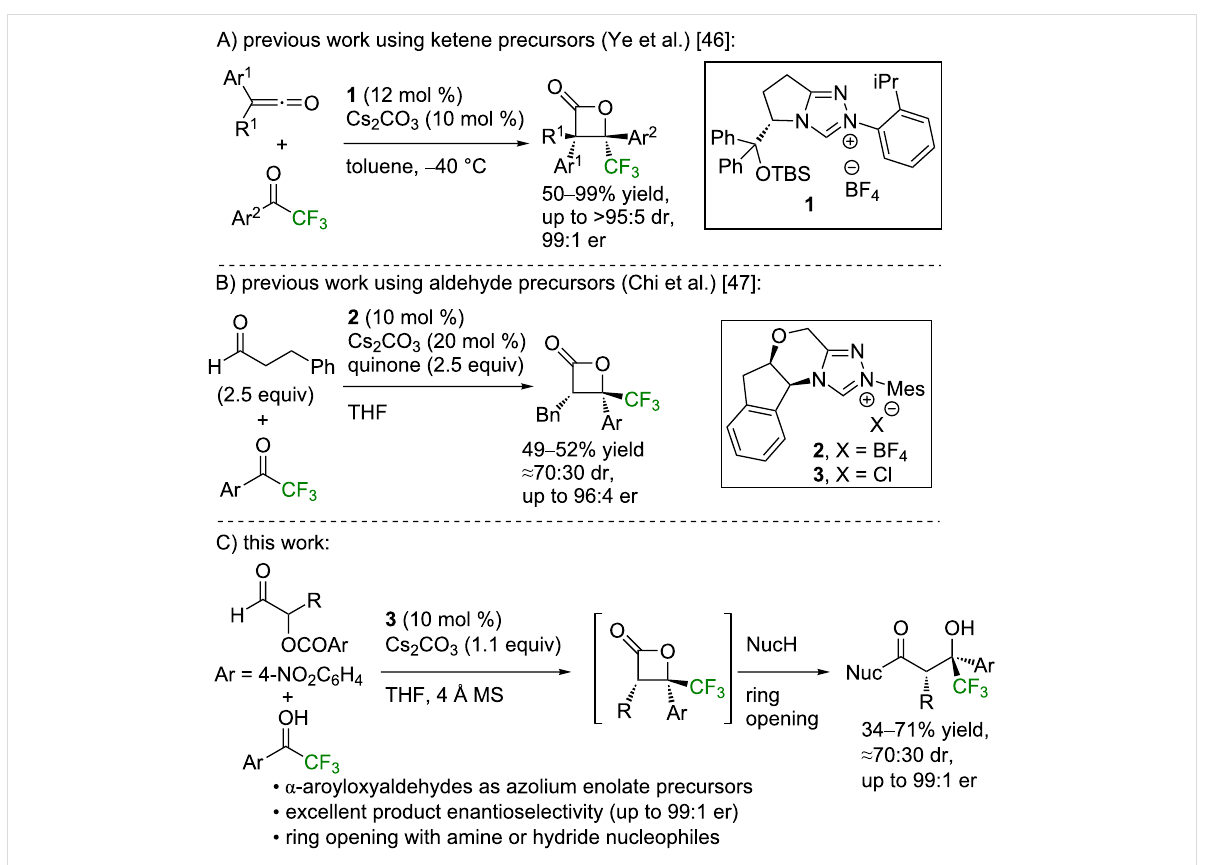
Figure 2: NHC-catalyzed approaches to β -lactones using trifluoroacetophenone derivatives.